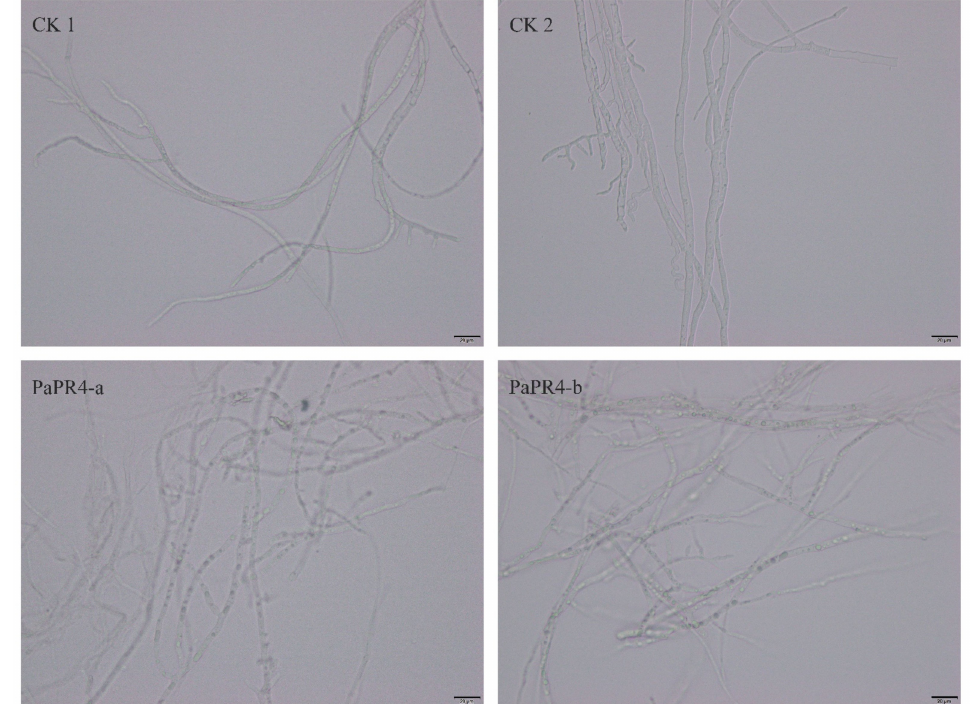
Figure 6. Antifungal activity of recombinant PaPR4-a and PaPR4-b proteins.CK1 and CK2 represent mycelia treated with sterile water and eluent, respectively, while PaPR4-a and PaPR4-b represent the experimental groups. Each experiment was performed in triplicate. The scale bar in the figure is 20 µ